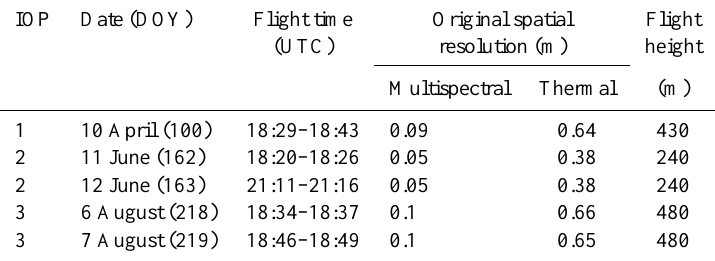
Table 1. Flight and pixel resolution information concerning the images obtained from the airborne campaigns. IOP Date (DOY) Flight time Original spatial Flight (UTC) resolution (m) height Multispectral